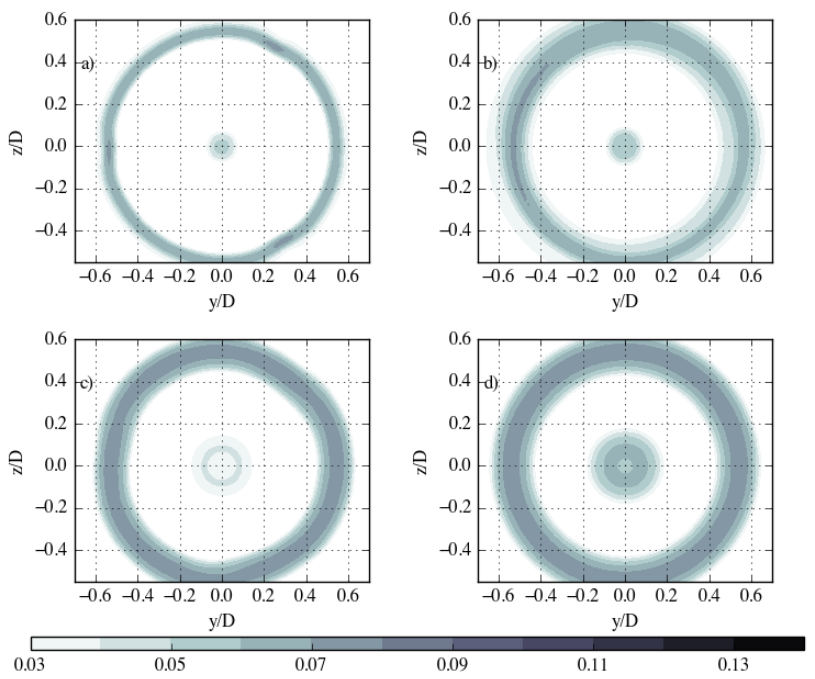
Figure 14. Numerical maps of normalised streamwise velocity standard deviation at x / D = 1 ( a , b ) and x / D = 3 ( c , d ) for the balanced rotor ( left column ) and + 5 ◦ unbalanced rotor ( right column